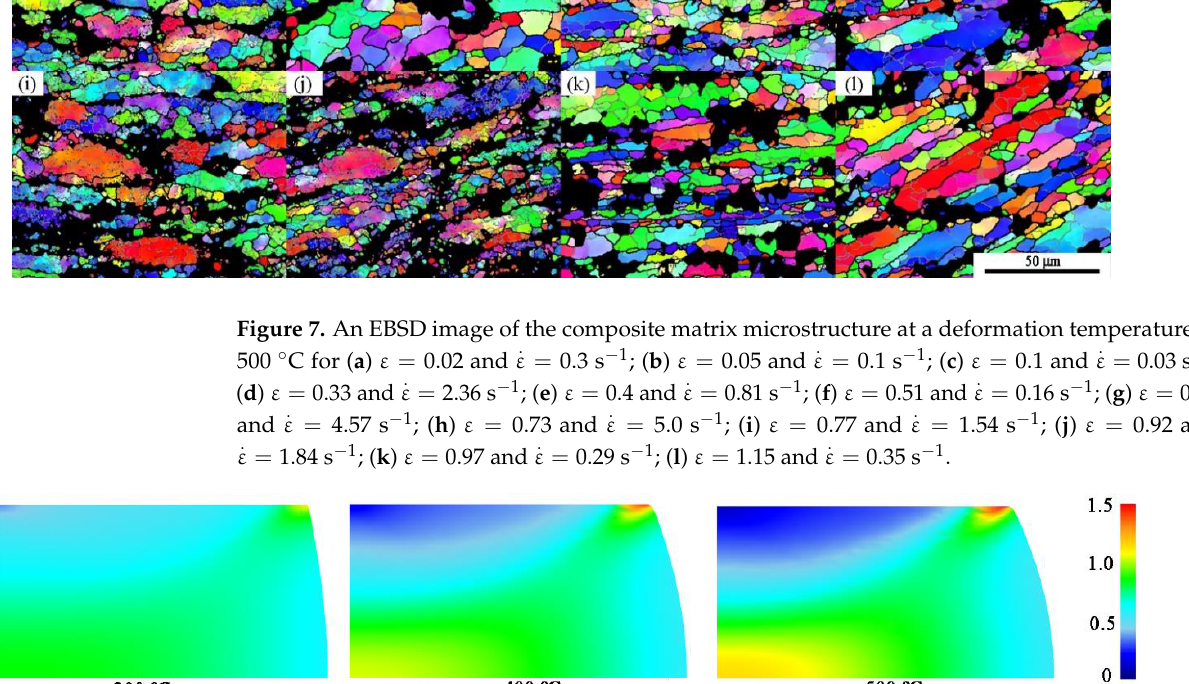
Figure 7. An EBSD image of the composite matrix microstructure at a deformation temperature of Table 3. Microstructure parameters of the AlMg6/10 % SiC MMC at temperatures of 300, 400, and 500 °C.